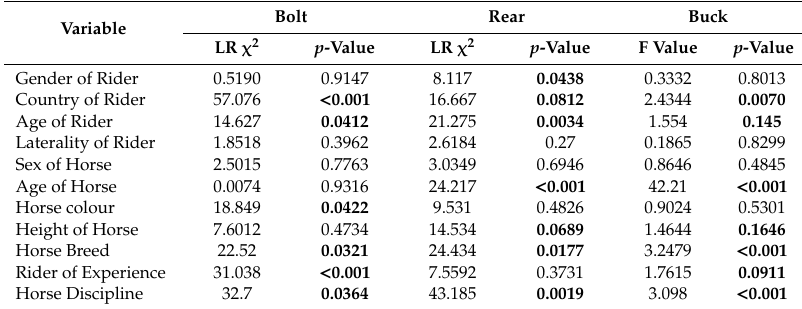
Table 3. The significance of likelihood ratio chi-square (LR χ 2 ) statistics for variables associated with incidence of bucking, rearing and bolting, as reported by the owners of 1584 ridden horses ( p values < 0.05 appear in bold).